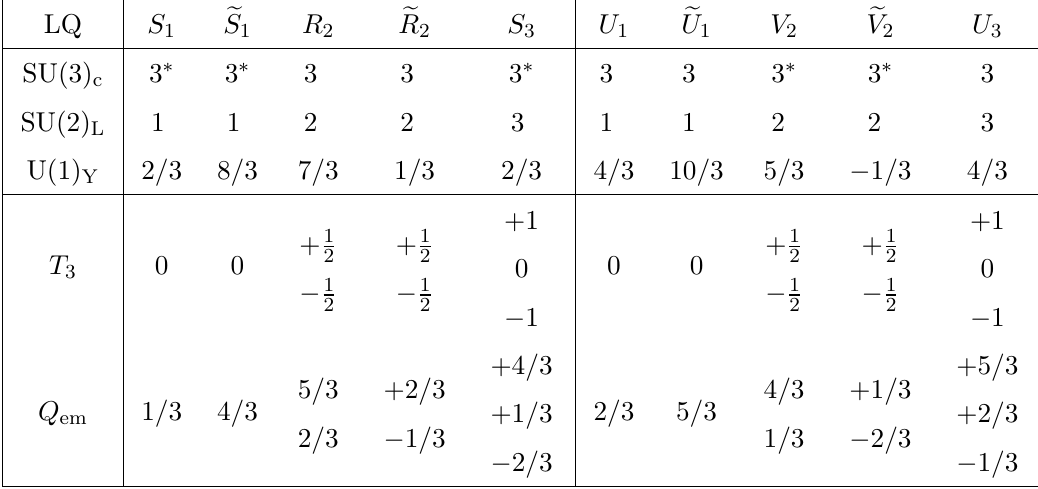
Table 4. Quantum numbers of LQ’s under the gauge groups of the SM, and the isospin T 3 and